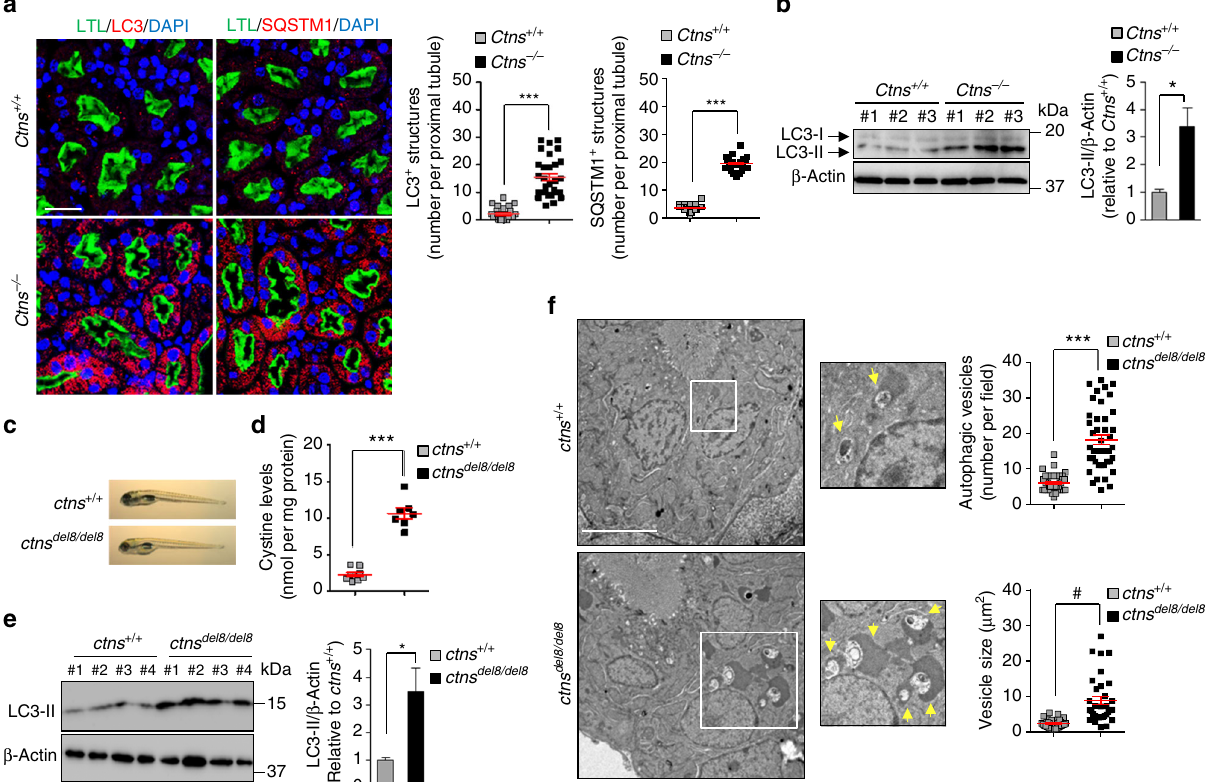
Fig. 2 Cystinosin de fi ciency alters autophagy in proximal tubules of mouse and zebra fi sh kidneys. a Representative confocal micrographs and quanti fi cation of numbers of LC3 + (left panel; red) or SQSTM1 + structures (right panel; red) in LTL + (green) proximal tubules in Ctns mouse kidneys ( n = 30 proximal tubules pooled from three kidneys per group; each point representing the number of LC3 + or SQSTM1 + vesicles in a proximal tubule; two-tailed unpaired Student ’ s t -test, *** P < 0.001 relative to Ctns + / + kidneys). Nuclei counterstained with DAPI (blue). b Western blotting and densitometric analyses of LC3 protein levels in whole kidney lysates from Ctns mice (two-tailed unpaired Student ’ s t -test, * P = 0.029 relative to Ctns + / + kidneys, n = 3 mice per group). c Representative images of ctns + / + and ctns del8/del8 zebra fi sh embryos at 5 dpf and d quanti fi cation of cystine levels by HPLC in ctns + / + and ctns del8/del8 zebra fi sh embryos at 5 dpf (two-tailed unpaired Student ’ s t -test,*** P < 0.001 relative to ctns + / + embryos, n = 8 ctns + / + zebra fi sh and n = 7 ctns del8/del8 zebra fi sh). e Western blotting and densitometric analyses of LC3 protein levels in pronephric tubules from 3-month-old ctns + / + and ctns del8/del8 zebra fi sh ( n = 4 per group; two-tailed unpaired Student ’ s t -test, * P = 0.03 relative to ctns + / + kidneys). f Representative electron micrographs and quanti fi cation of numbers and size of autophagic vacuoles in pronephric tubules of ctns + / + and ctns del8/del8 zebra fi sh embryos at 5 dpf. White squares contain images at higher magni fi cation. Yellow arrowhead indicates autophagic vacuoles. Number of autophagic vesicles: n = 43 ( ctns + / + ) and n = 42 ( ctns del8/del8 ) randomly selected micrographs were pooled from 11 ctns + / + and 12 ctns del8/del8 zebra fi sh. Average vesicle size: n = 32 ( ctns + / + ) and n = 33 ( ctns del8/del8 ) randomly selected micrographs were pooled from 11 ctns + / + and 12 ctns del8/del8 zebra fi sh. Two-tailed unpaired Student ’ s t -test, *** P < 0.001 and # P < 0.0001 relative to ctns + / + zebra fi sh. β -Actin was used as a loading control in b and e . Plotted data represent mean ± SEM. Scale bars are 50 μ m in a and 5 μ m in